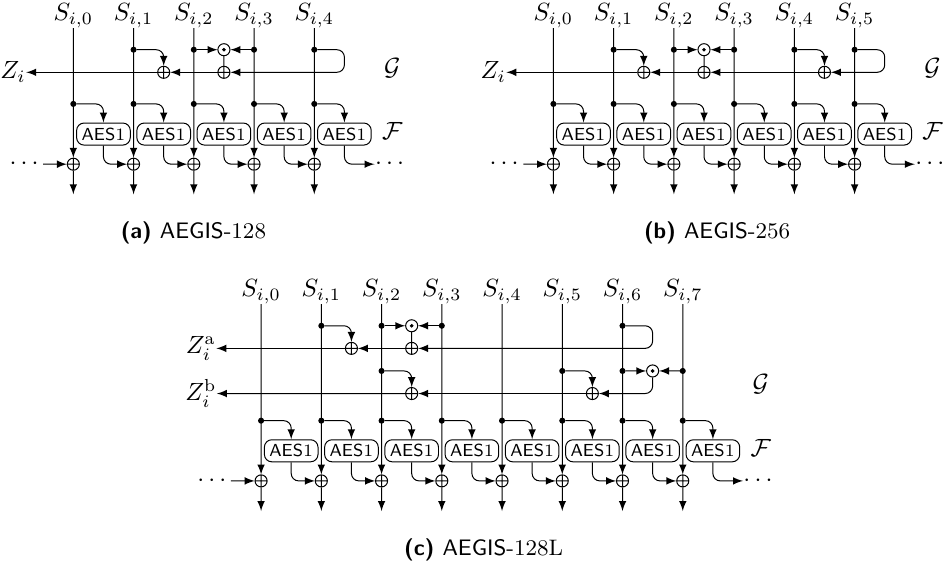
Figure 1: State update function of the AEGIS family